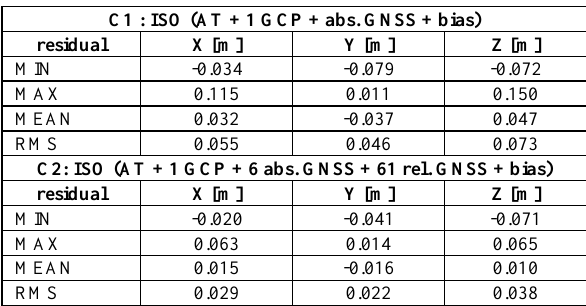
Table 5. Case C: Summary of integrated SO on projects with GNSS positioning bias